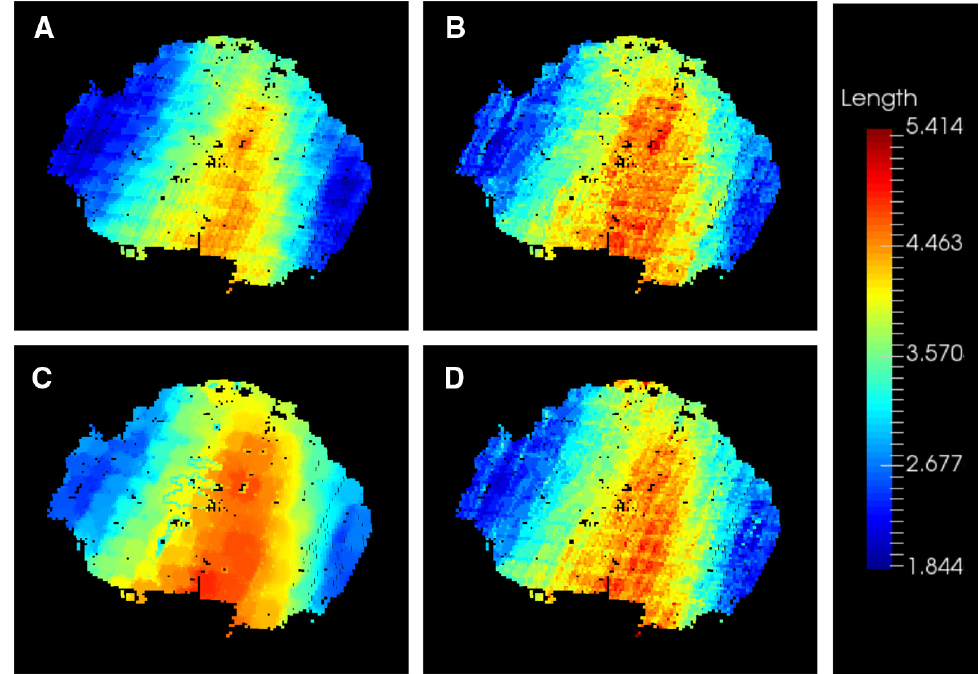
Figure 4: Thickness values (mm) of lateral cartilage projected along the z-axis. Only the voxels that all methods assigned a value to are shown. (A) Nearest neighbor. (B) Surface normals. (C) Local thickness. (D) Field lines.